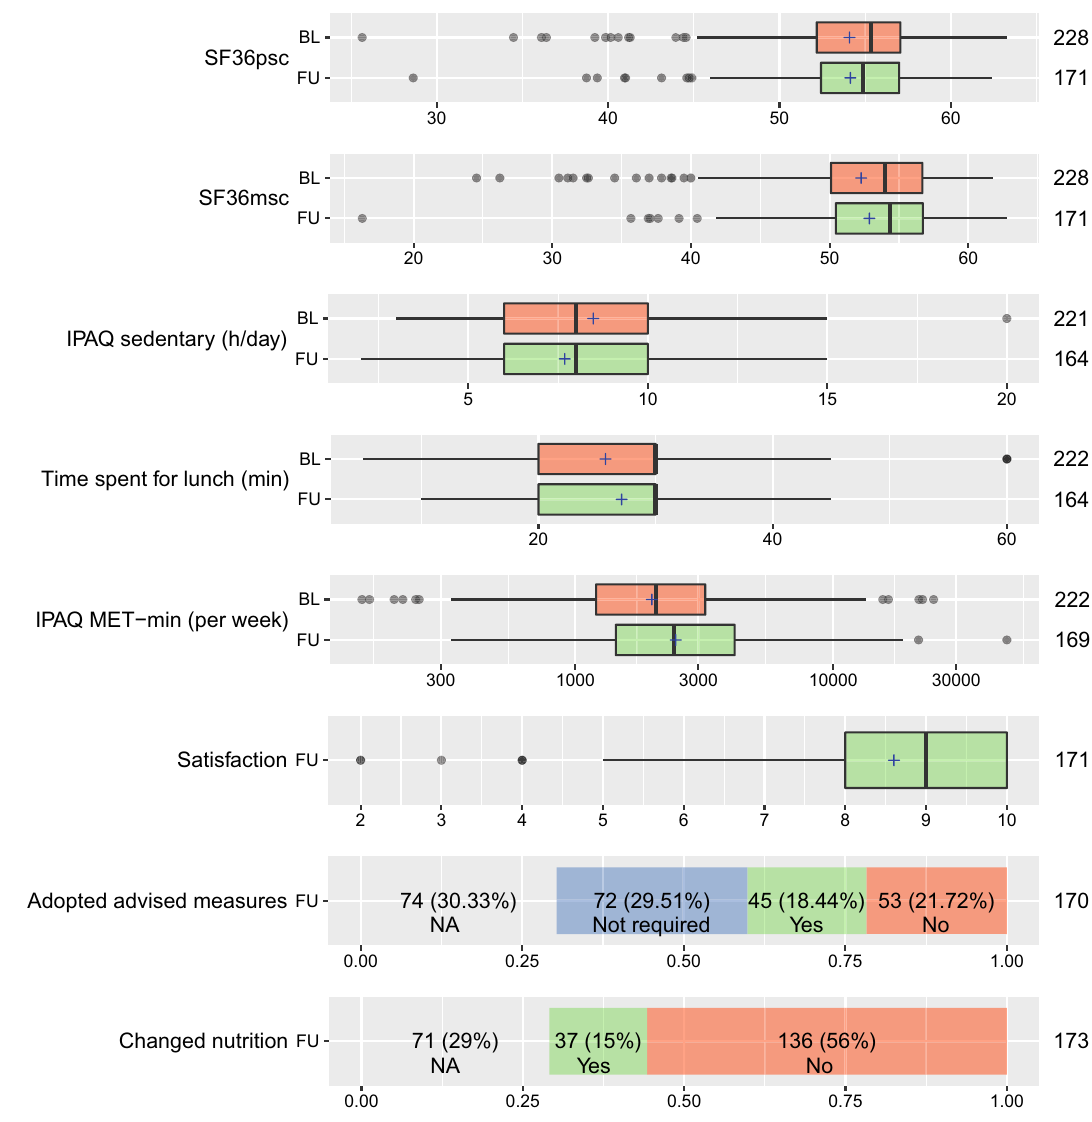
Figure 2. Outcome measures at baseline and follow-up in the whole cohort. Dots values of outliers, whiskers 95% interval, box interquartile range, line within box median value, cross within box = arithmetic mean, nominal data in bars: number (percent of all participants). BL baseline, FU follow-up, n number, min minute, h hour, IPAQ International Physical Activity Questionnaire, MET-min metabolic equivalent of task per minute, NA number of missing values, SF36msc mental health subscale of the Short-Form Health Survey, SF36psc physical health subscale of the Short-Form Health Survey. Graph was created with R 12